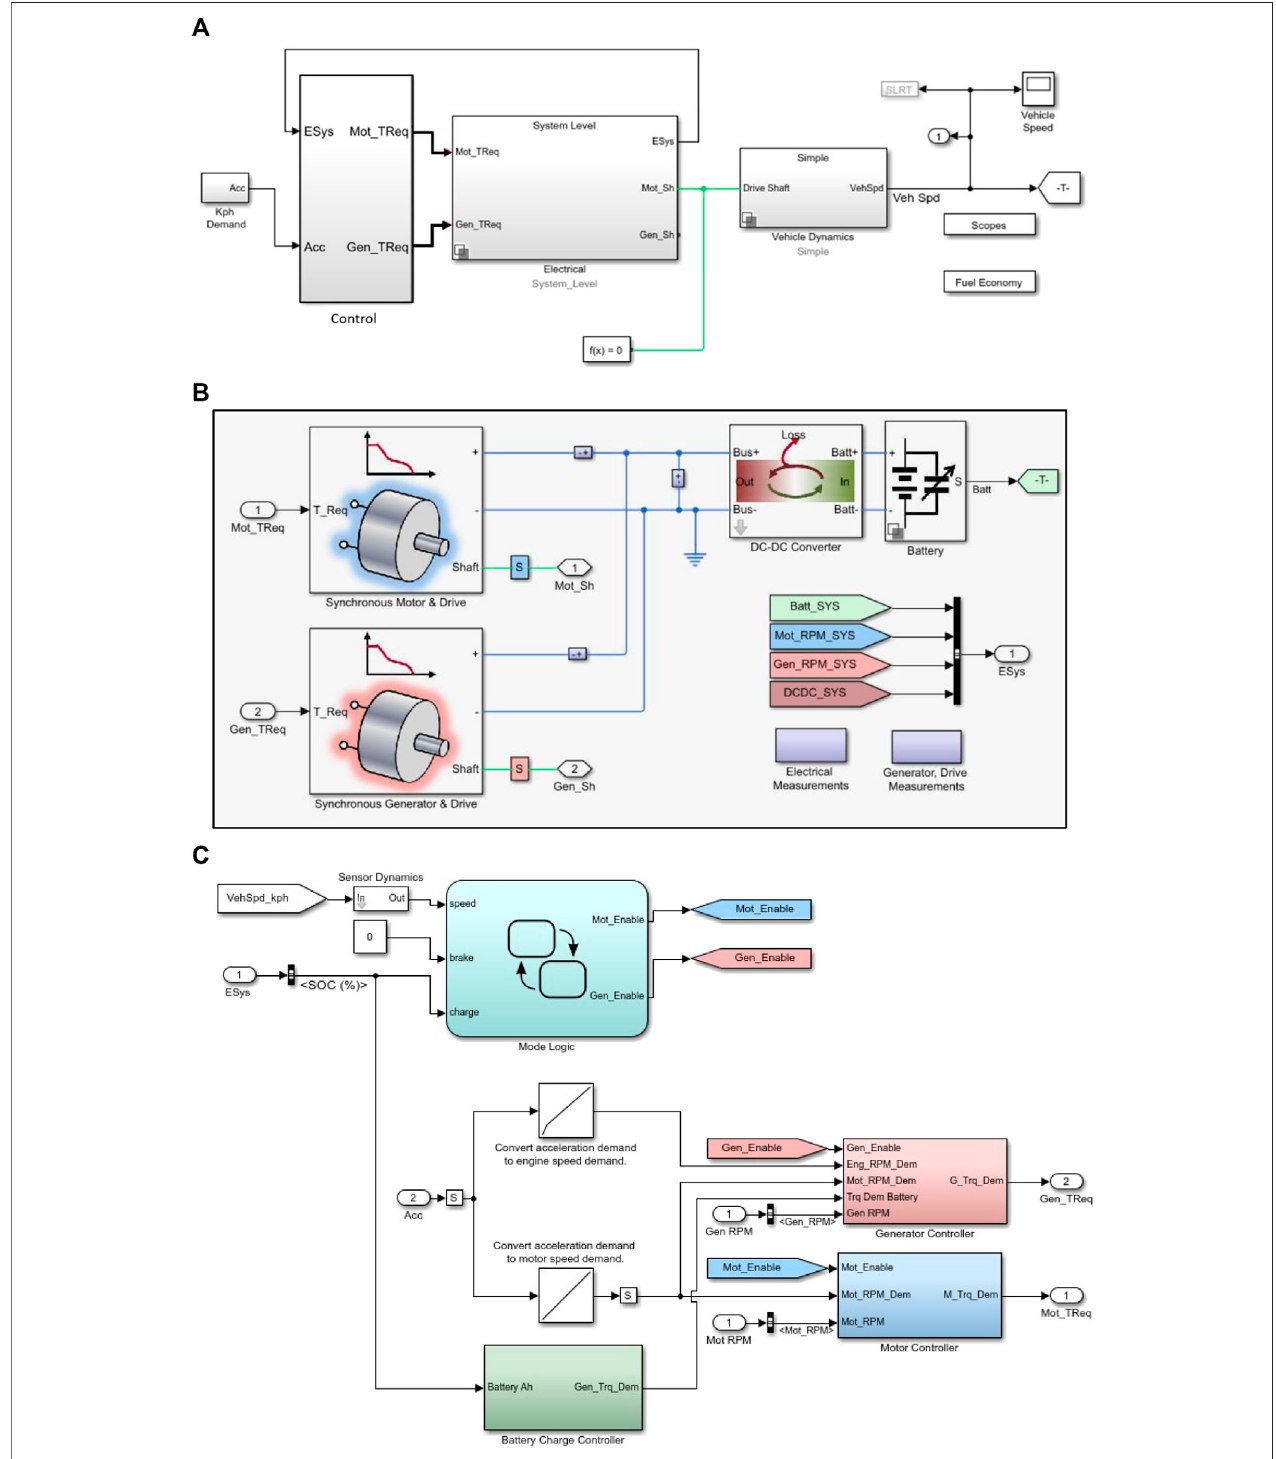
FIGURE 8 | Simulink Models of (A) Block of a BEV (Chen and Rincon-Mora, 2006) (B) Electrical system con fi guration and (C) Control system con fi guration.